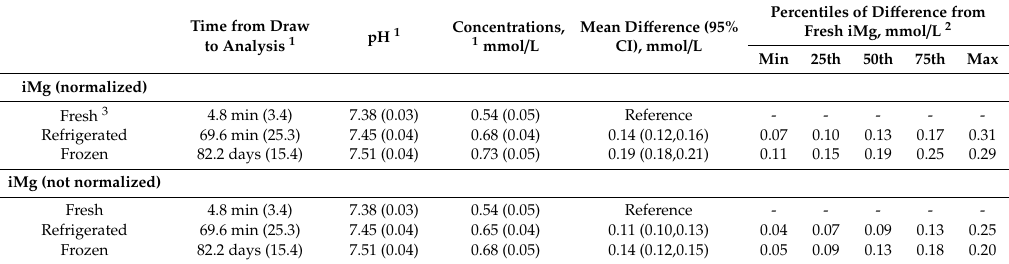
1 Mean (standard deviation); 2 the distribution (in percentiles) of the difference between refrigerated